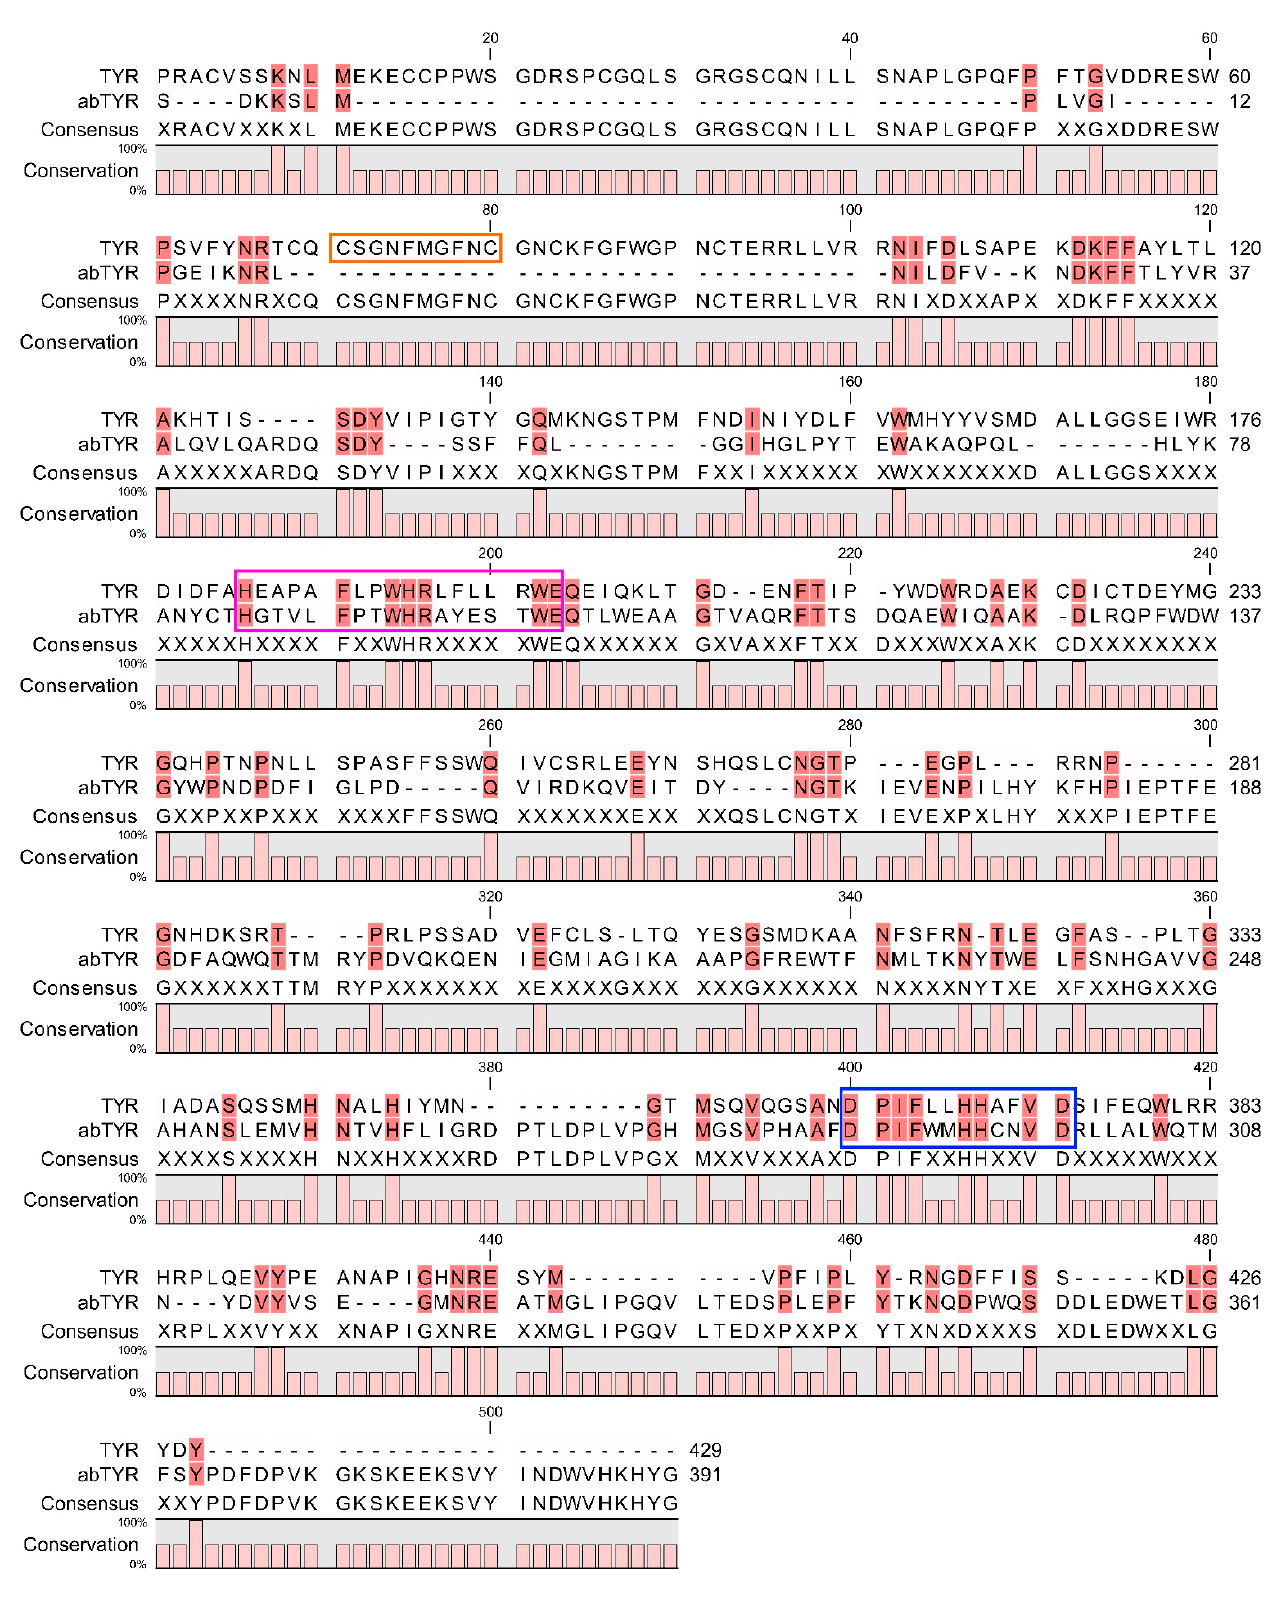
Figure 2. Pairwise sequence alignment of TYR and abTYR sequences used in this study. Magenta, CuA binding pattern; blue, CuB binding pattern; orange, EFG pattern. TYRP1 and TYRP2 are the enzymes responsible for the subsequent reactions in mel ‐ anin formation (Figure 1). The TYRP1 crystal structure is known (5M8L) and was used in